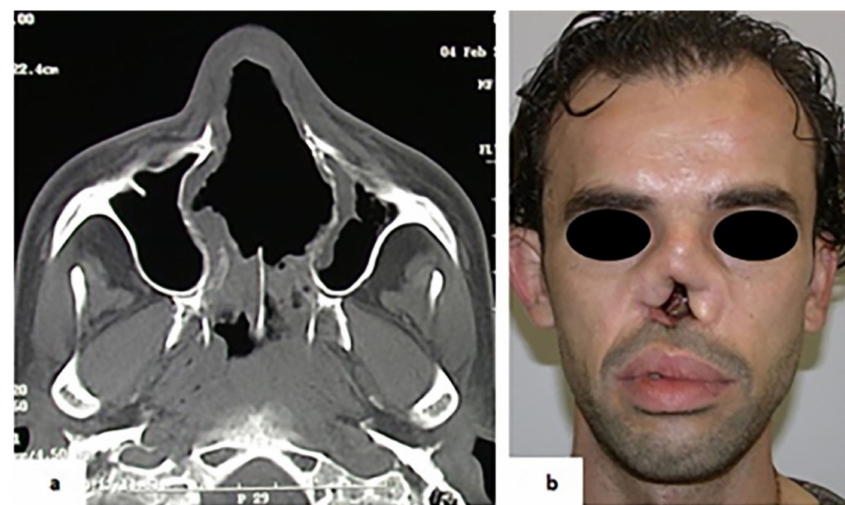
Figure 2. ( a ) Case 5. Destruction of bony and cartilaginous septum revealed by CT scan. ( b ) Typical saddle-nose deformities with columellar retraction and nasal